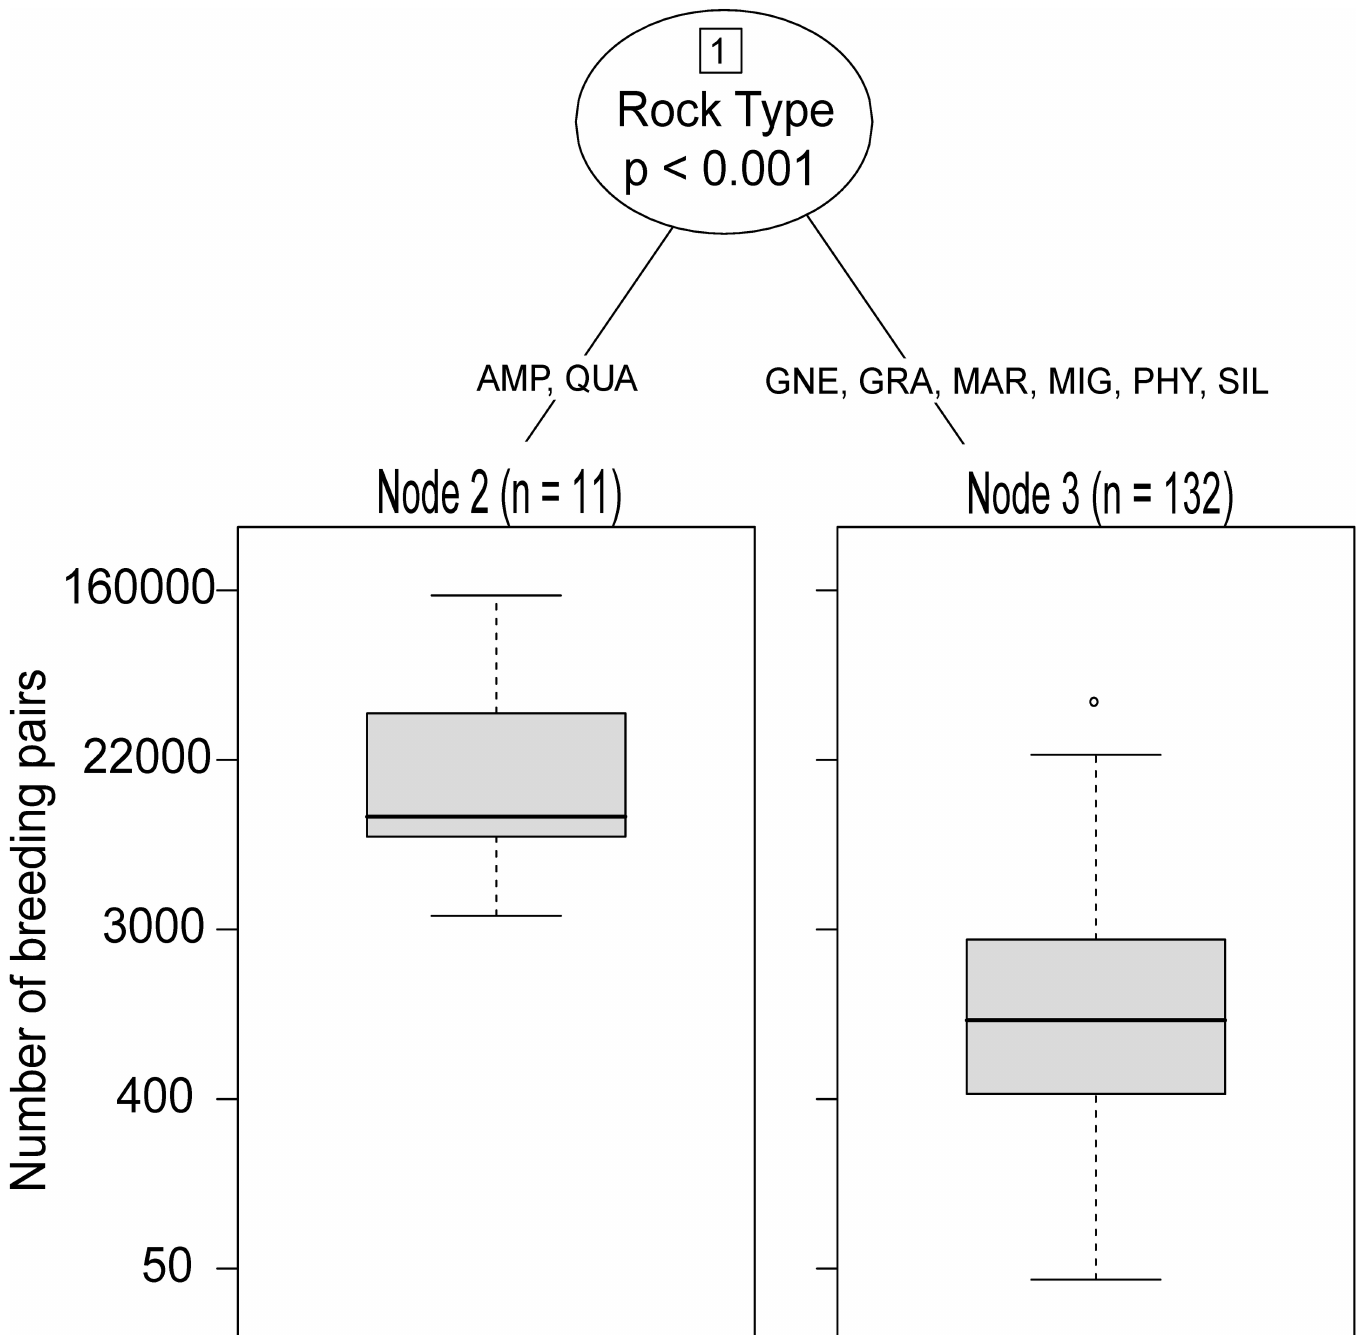
Fig 6. Conditional Inference Tree characterizing factors related to the size of the little auk colonies in W and NW coast of Spitsbergen (number of pairs) based on quantitative (altitude, slope, aspect, average solar insolation in May, distance to the nearest foraging hotspot [mean values per polygon]) and quantitative (type of rocks) predictors. Encircled variable is significantly (p < 0.001) related to the response variable (colony size). The p value shown in an encircled node represents the test of independence between the variable (type of rocks) and the response variable (colony size). N in terminal nodes indicates the number of colonies corresponding to specific type of rocks. Histograms in terminal nodes (nodes 2, 3) depict the size of colonies in particular groups differing in type of rocks. Boxplots show the median (band inside the box), the first (25%) and third (75%) quartile (box), the lowest and the highest values within 1.5 interquartile range (whiskers) and outliers (circles). Rock type codes: AMP–amphibolite, QUA- quarzite, GNE–gneiss, GRA–granite, MAR—marble, MIG–migmatite, PHY–phyllite, SIL–silt.